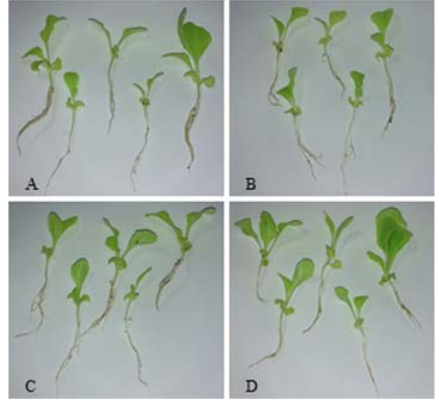
Fig. 4: Lettuce cultivated in soils containing A) Control, B) Ag + _bentonite, C) Ag + _phosphate and D) AgNp_silica